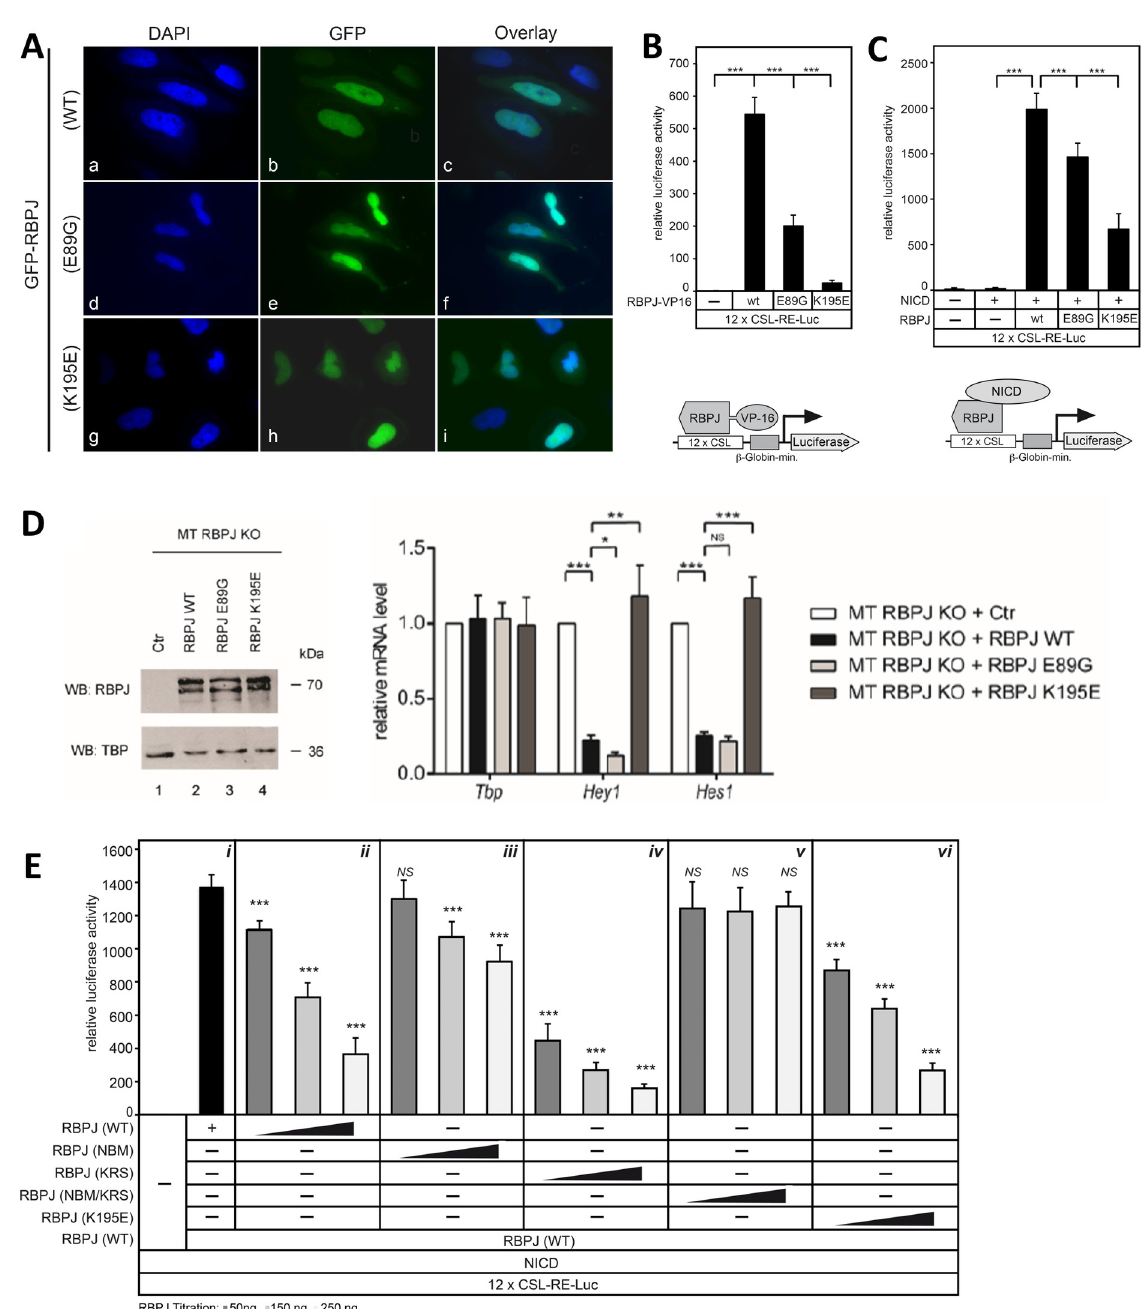
Fig 7. The RBPJ AOS variants show dysregulated Notch target gene expression when compared to WT RBPJ. A. Subcellular localization of Rbpj proteins after expression in HeLa cells, illustrating predominantly nuclear localization of both WT and variant Rbpj proteins. HeLa cells were transiently transfected with 0.3 μ g of the respective GFP-Rbpj plasmids: WT, E89G, and K195E. After 24 hours, cells were fixed and stained with DAPI and imaged under a fluorescent microscope using a 63x objective. B. Luciferase reporter assay using an Rbpj-VP16 fusion to test for DNA binding capacities (schematic lower panel). Both Rbpj K195E-VP16 and E89G-VP16 show reduced reporter signal compared to WT, consistent with the observation that both have impaired DNA binding. HeLa RBPJ-KO cells were transfected with the Notch/RBPJ dependent reporter 12xCSL-RE-Luc (250 ng) without or with the indicated Rbpj-VP16 constructs (10 ng). Luciferase activity was measured 24 hours after transfection. Bars represent mean values from six independent experiments; error bars indicate standard deviation, ��� p < 0.001. C. Transactivation capacities of RBPJ WT and AOS variants together with NICD. HeLa RBPJ-KO cells were transfected with the Notch/ RBPJ dependent reporter 12xCSL-RE-Luc (250 ng) without or with the indicated Rbpj constructs (50 ng) and the NICD expression plasmid (10 ng) (schematic lower panel). In RBPJ depleted HeLa cells, NICD is not able to transactivate the reporter. Together with NICD, the